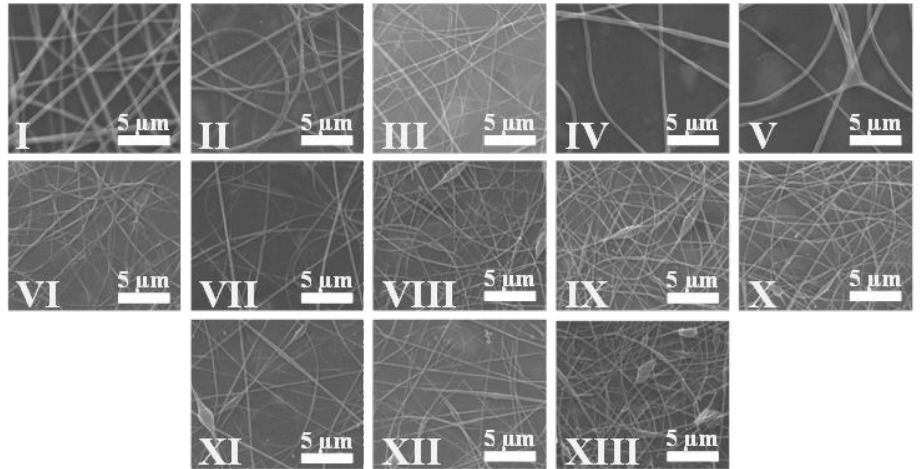
Figure 1. SEM images of the different electrospun mats obtained from run I to run XIII of the experimental worksheet in Table 1. Table 2. Efibers experimental responses: Average diameter values, glass transition temperature, T g , and degree of crystallinity, X c